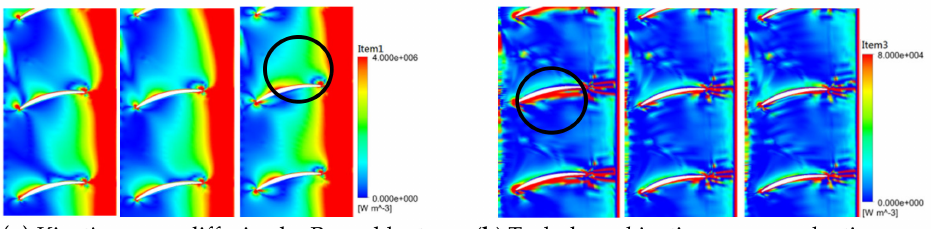
Figure 12. Distribution of the losses for vane ( left : 0.5 Ud, middle : 1.0 Ud, right : 1.7